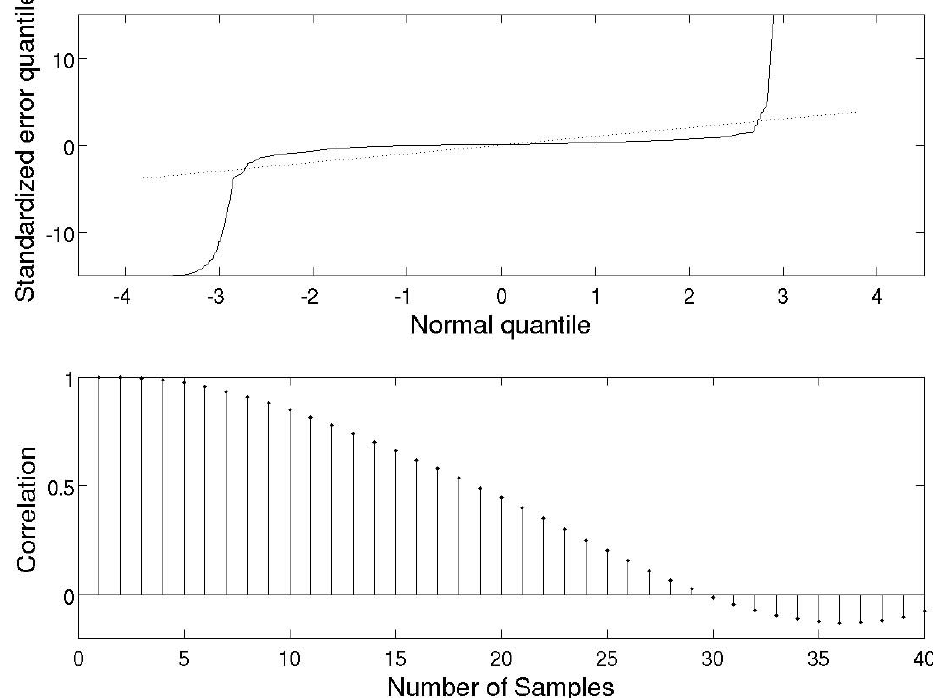
Fig. 3. Summary plots of the analysis of the 6h forecast residuals at Welsh Bridge for the DT model calibrated using the Gaussian maximum likelihood methodology. The upper pane shows the quantile-quantile plot of the standardised residuals compared to a standard normal distribution. The lower pane shows the auto-correlation of the